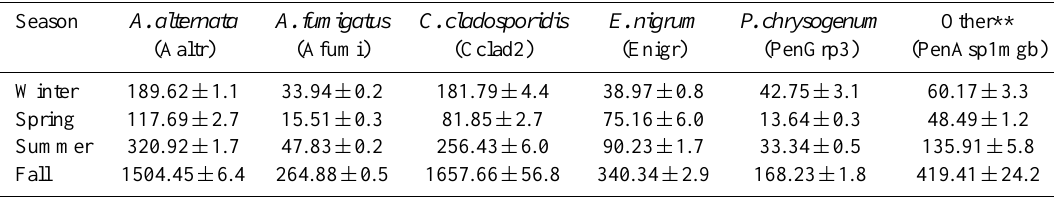
Table 2. Seasonally averaged values of fungal species concentrations, analyzed by qPCR*.